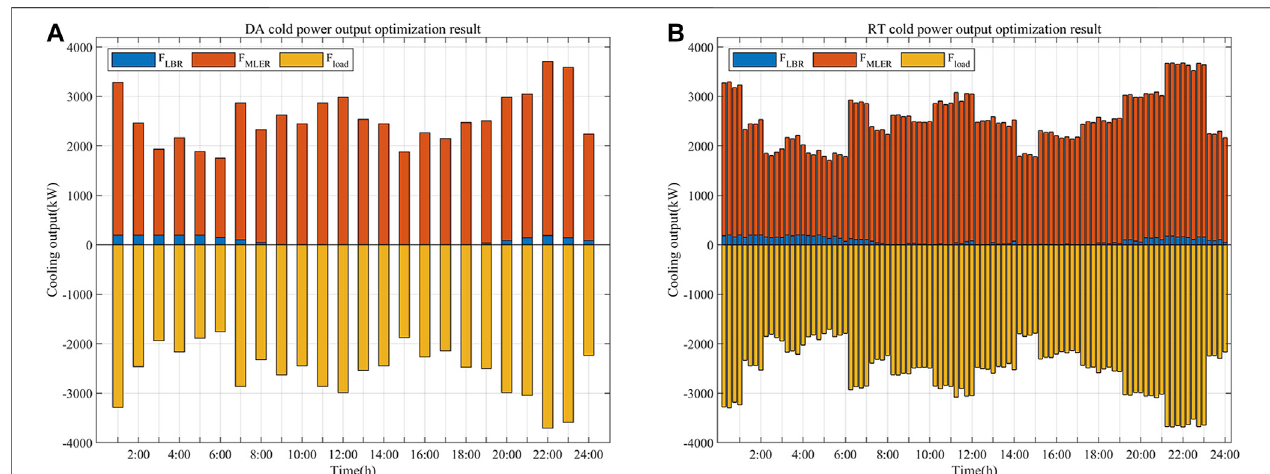
FIGURE 8 | DA and RT cold power output optimization